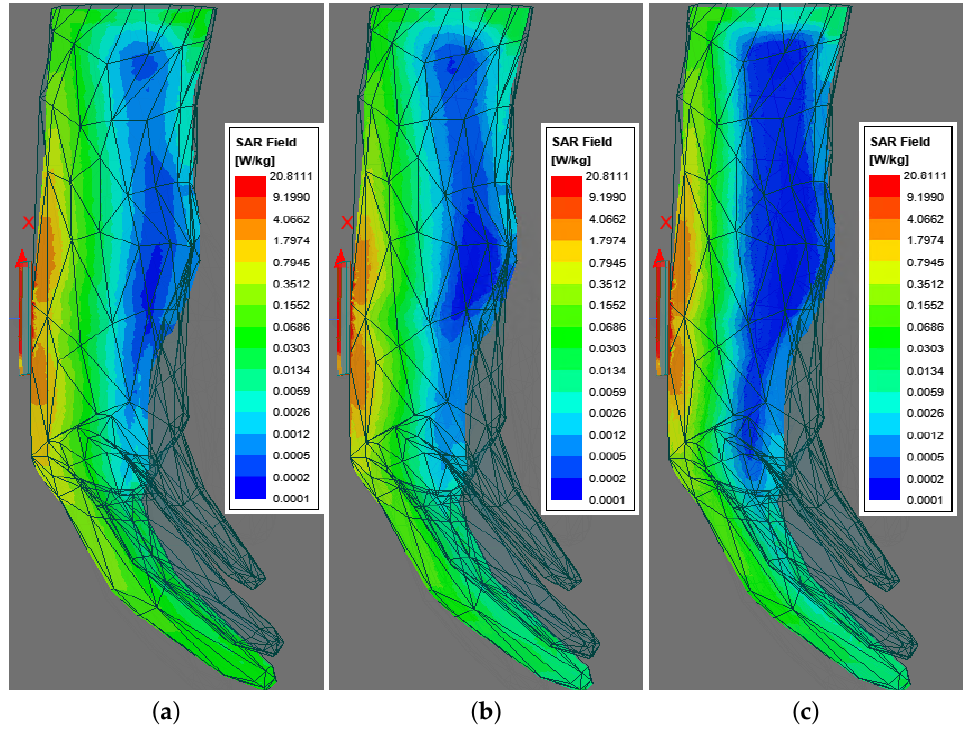
Figure 22. SAR avg plot on the XoZ -plane when d ant = 0 mm. ( a ) SAR avg at 5.8 GHz; ( b ) SAR avg at 6.2 GHz; and ( c ) SAR avg at 8.4